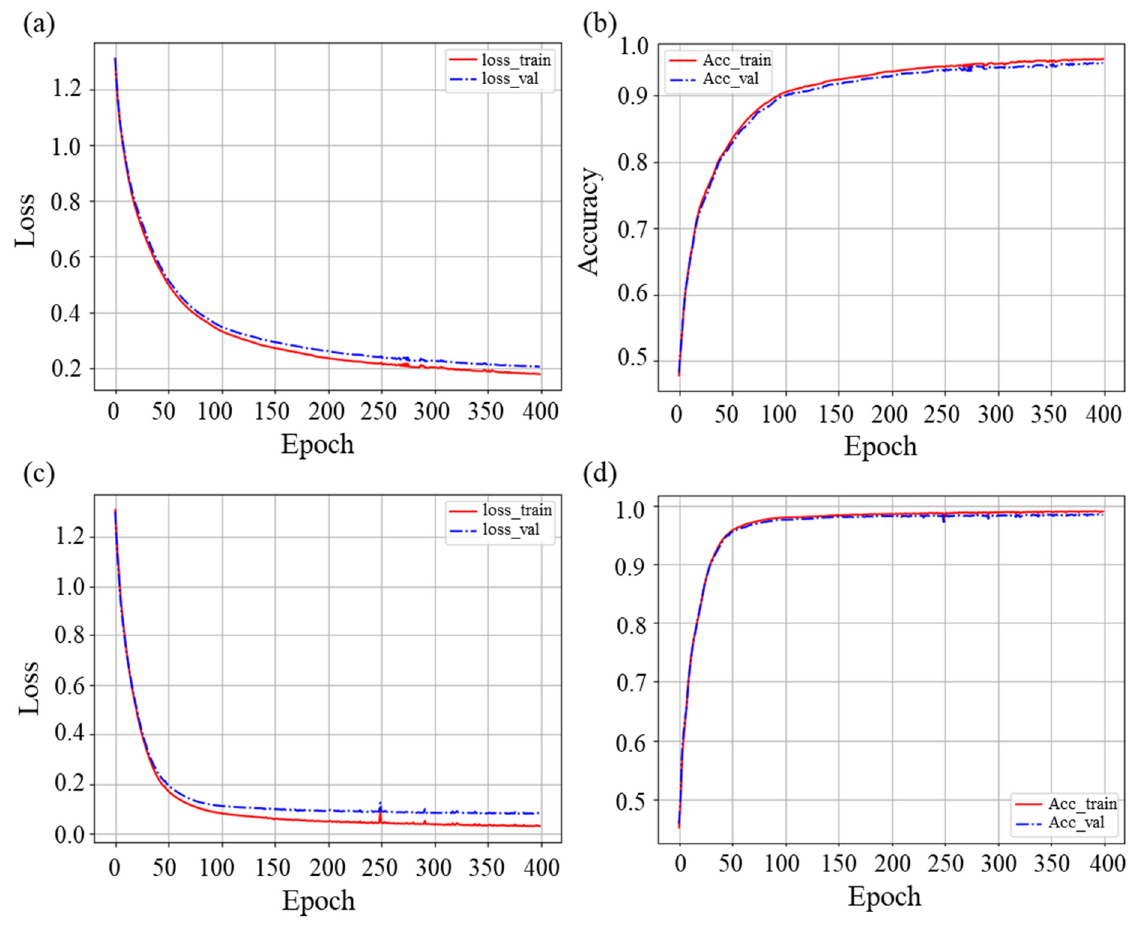
Figure 10. The loss curve and ACC curve of the LSTM and BiLSTM neural networks: ( a ) loss curve of LSTM neural network; ( b ) ACC curve of LSTM neural network; ( c ) loss curve of BiLSTM neural network; ( d ) ACC curve of BiLSTM neural network.